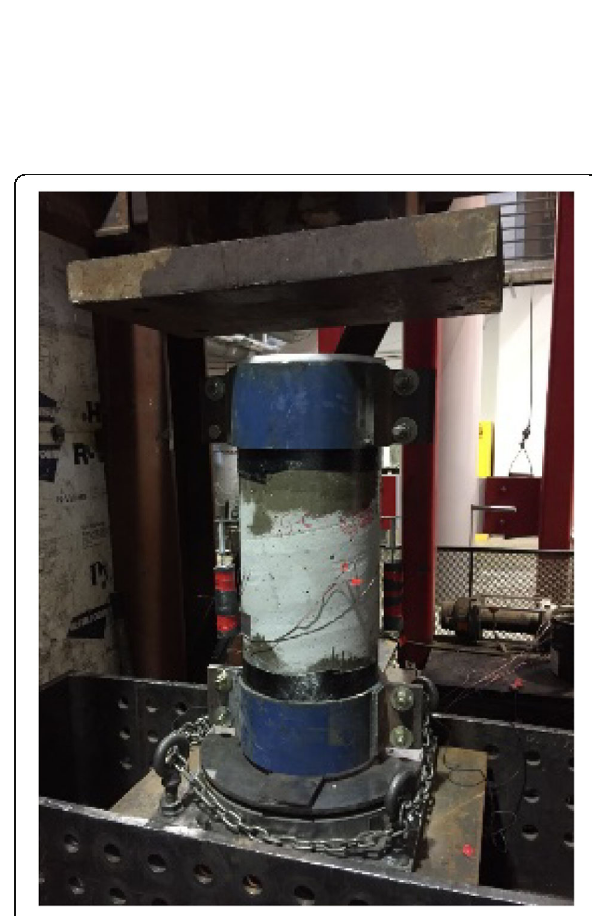
Fig. 8 Axial compression test setup with two